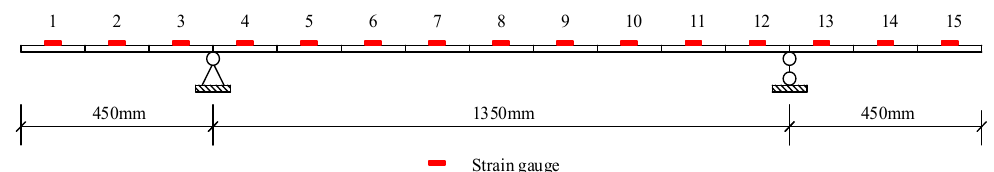
Figure 1. The model of simply supported overhanging beam.